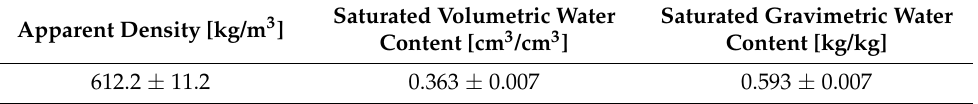
Table 1. Basic physical properties of the examined material.